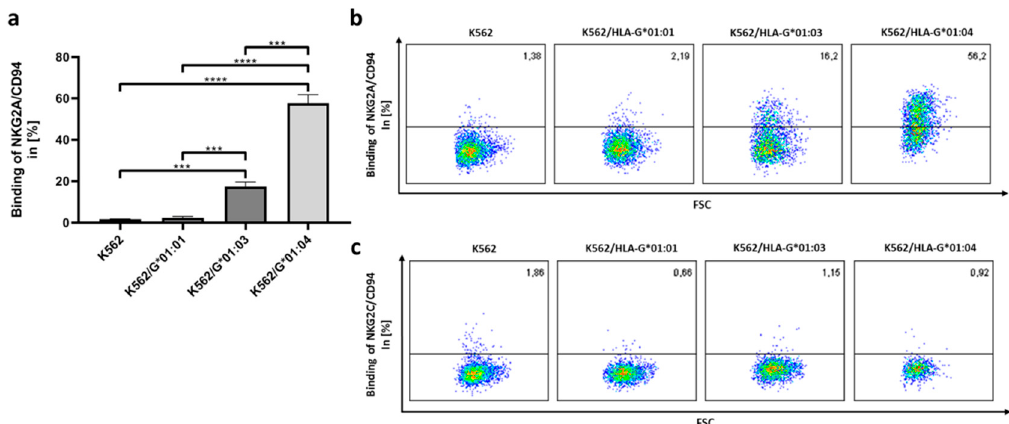
Figure 2. NKG2A/CD94 distinguishes amino acid (AA) differences in the HLA-G heavy chain. ( a ) K562/HLA-G*01:01 , K562/HLA-G*01:03, or K562/HLA-G*01:04 and K562 cells were analyzed for NKG2A/CD94 binding. Cells were incubated with sNKG2A/CD94 coupled to V5-His-tag . Binding was detected by an anti-V5 antibody and a PE labelled secondary antibody. Experiment was performed in triplicates ( n = 3). Significance of (***) describes a p -value of p < 0.001 and significance of (****) describes a p -value of p < 0.0001; ( b ) Representative FACS plots for the binding of sNKG2A/CD94 and ( c ) sNKG2C/CD94. Depicted numbers in each plot indicate the binding of NKG2/CD94 in percentage.